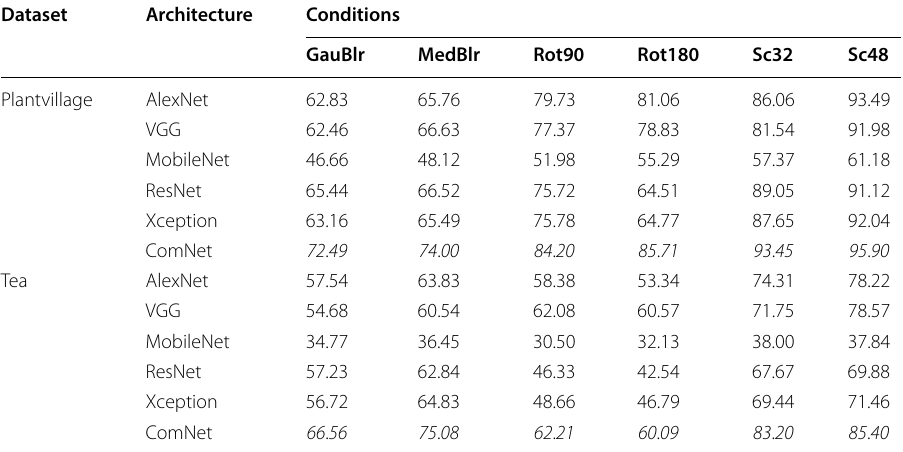
The best performance for each transformation is printed in italics